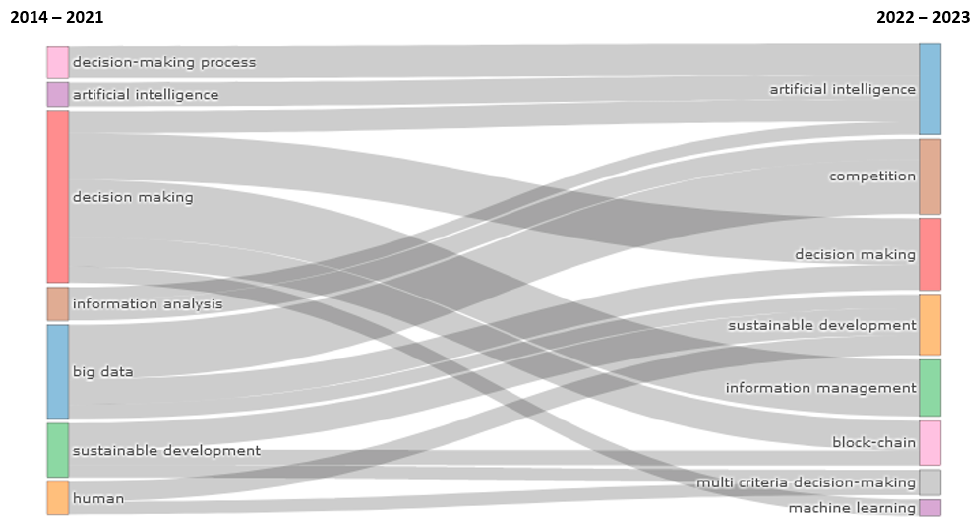
Figure 12. Thematic evolution map based on keywords plus terms.